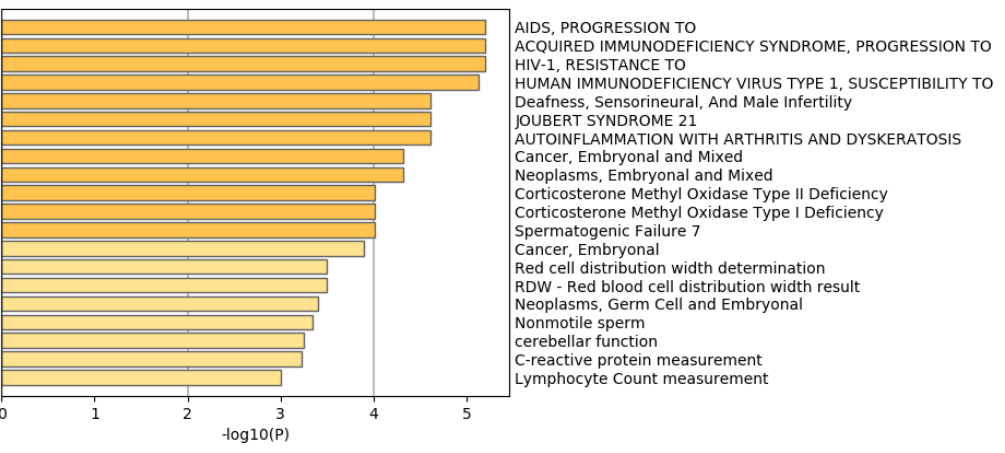
Figure 15. Summary of enrichment of the DisGeNet category of Metascape when 962 protein-coding genes included in 1447 genomic regions selected by categorical regression are